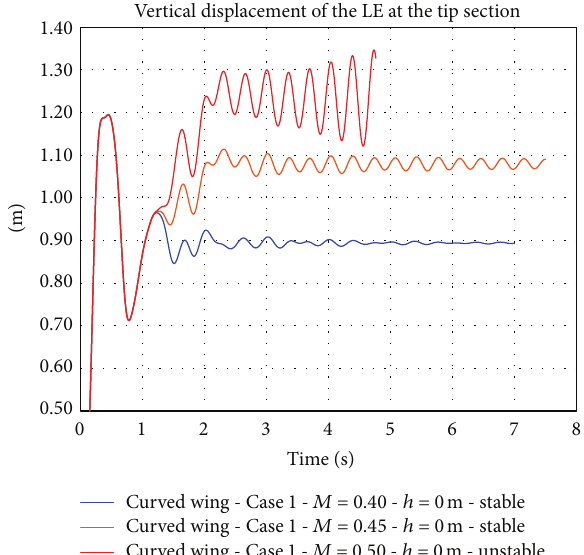
Figure 8: Results of the FSI analyses of the curved wing (Case 1 , sea level).